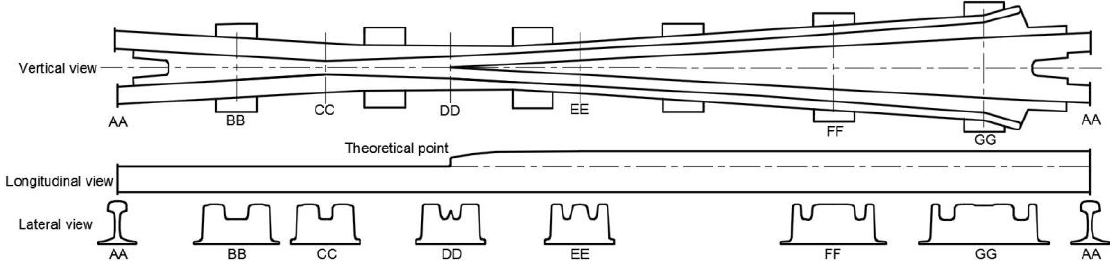
Figure 8. The geometry of the 1:9 cast crossing with defined critical cross-sections (drawing from Y. Ma).